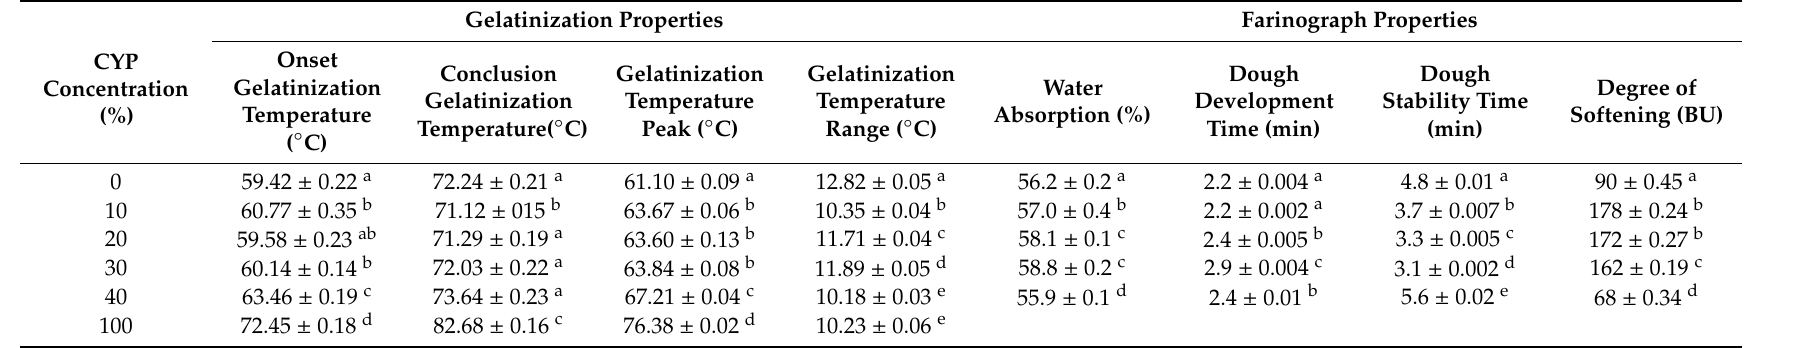
Table 2. Gelatinization and farinograph properties of wheat flour–yam powder